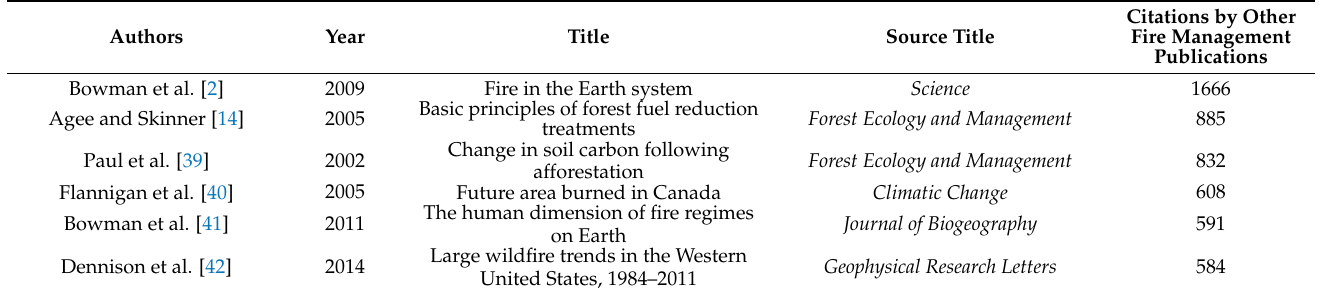
Table 2. Most-influential publications on fire management by number of citations registered in Scopus